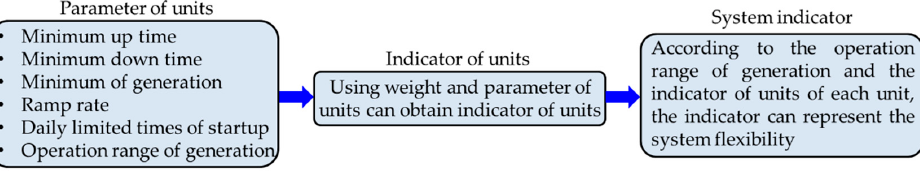
Figure 4. Calculation of flexibility index by FAHP [2].